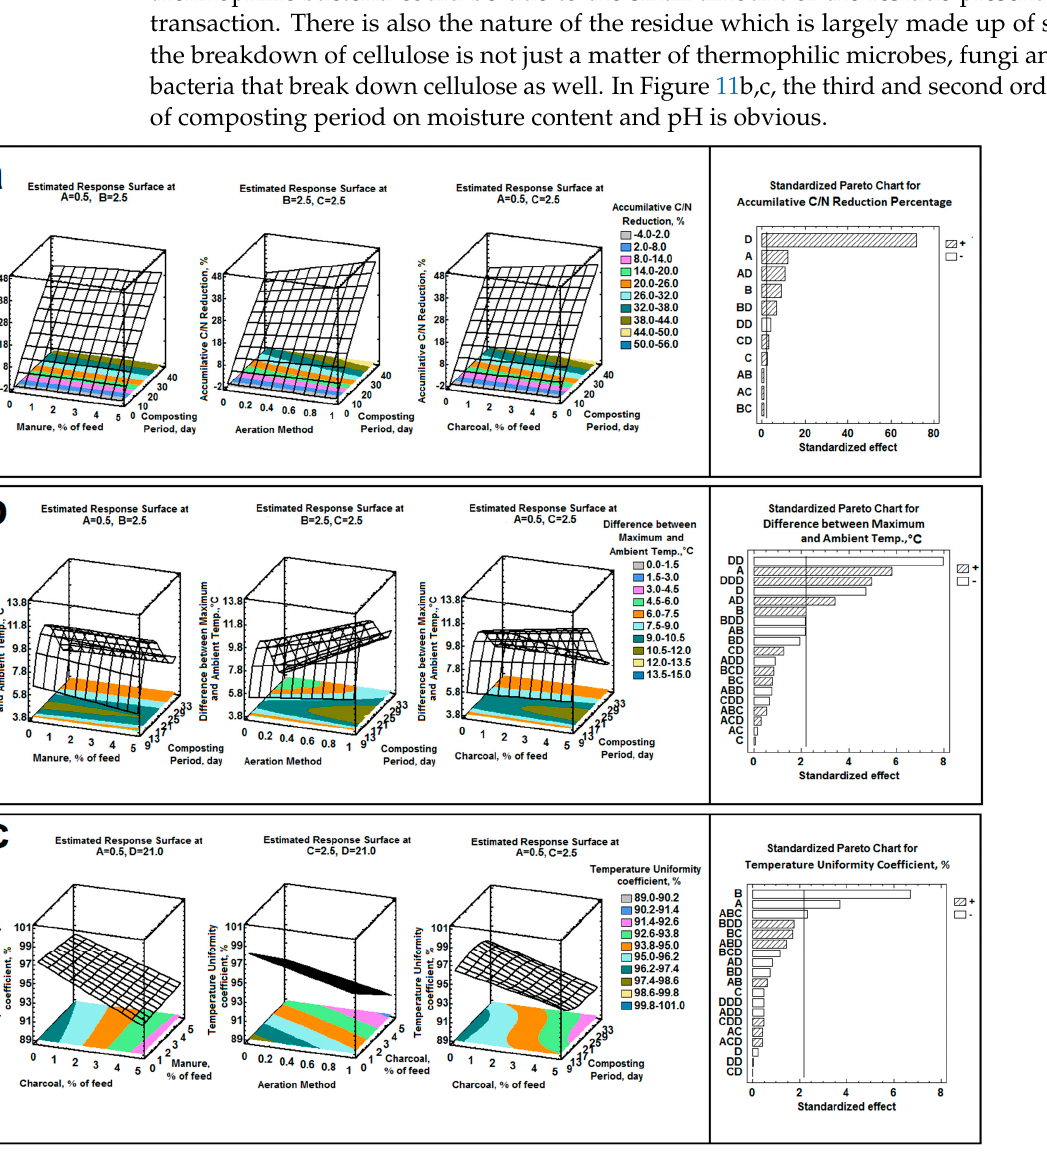
Figure 10. Estimated response surfaces and their contours below as a function of each two factors at a constant value of other factors with Pareto charts for each response of ( a ) accumulative C/N re- duction percentage; ( b ) difference between maximum and ambient temperature; and ( c ) tempera- ture uniformity coefficient.